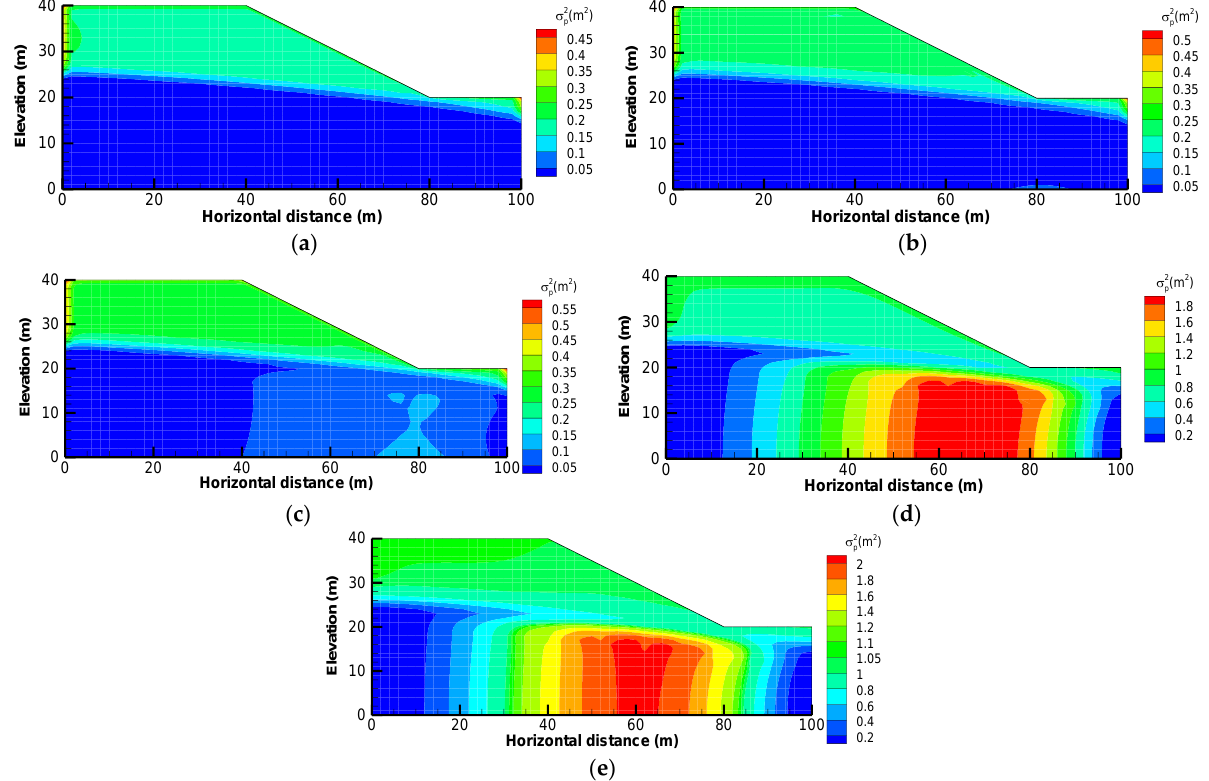
Figure 4. Pressure head variance at steady state for various correlation lengths of ln ( K s ) : ( a ) ρ = 0.1 m ; ( b ) ρ = 0.5 m ; ( c ) ρ = 1 m ; ( d ) ρ = 10 m and ( e ) ρ = 100 m .